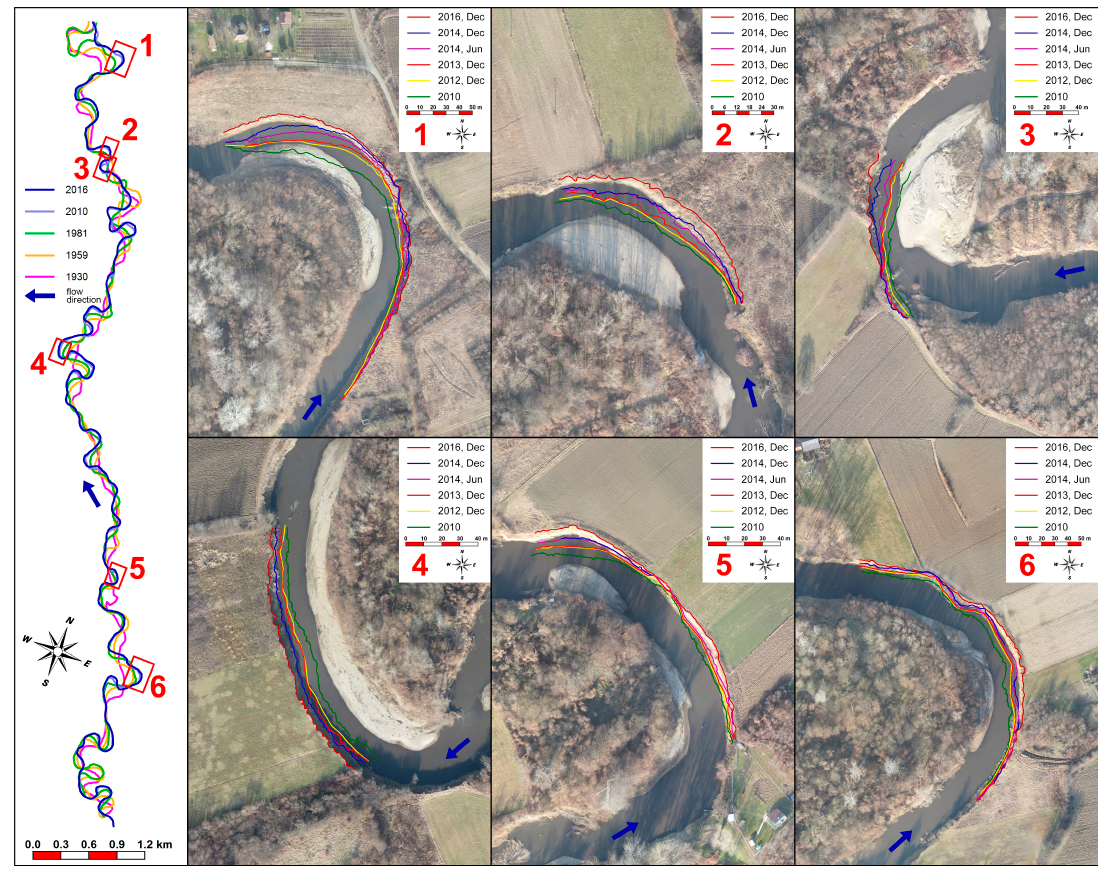
Figure 5. Bank erosion on six meanders in between 2010 and 2016. Table 5. Erosion plots (land loss) in monitored